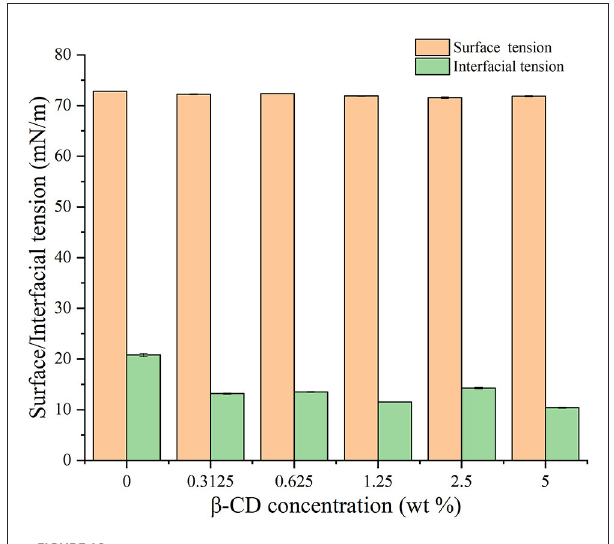
FIGURE12 Effects of different concentrations of β -CD on water–vapor surface tension and oil–water interfacial tension.